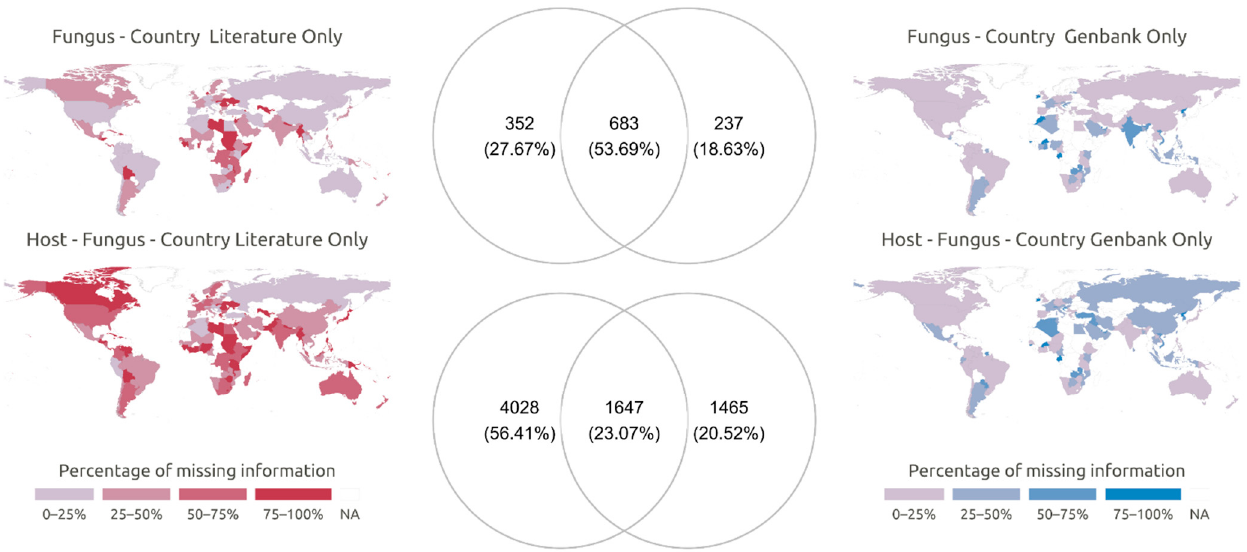
Figure 9. Worldwide percentage of missing information in both the literature and GenBank datasets by country for occurrence and host–fungus interactions.